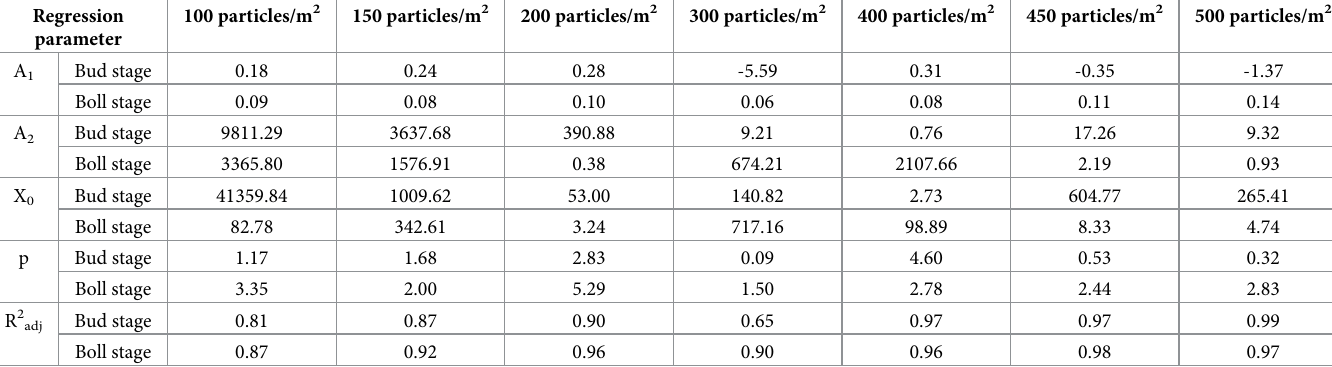
Table 3. Regression parameters of logistic functions between the branch breaking rate and hail size. Regression